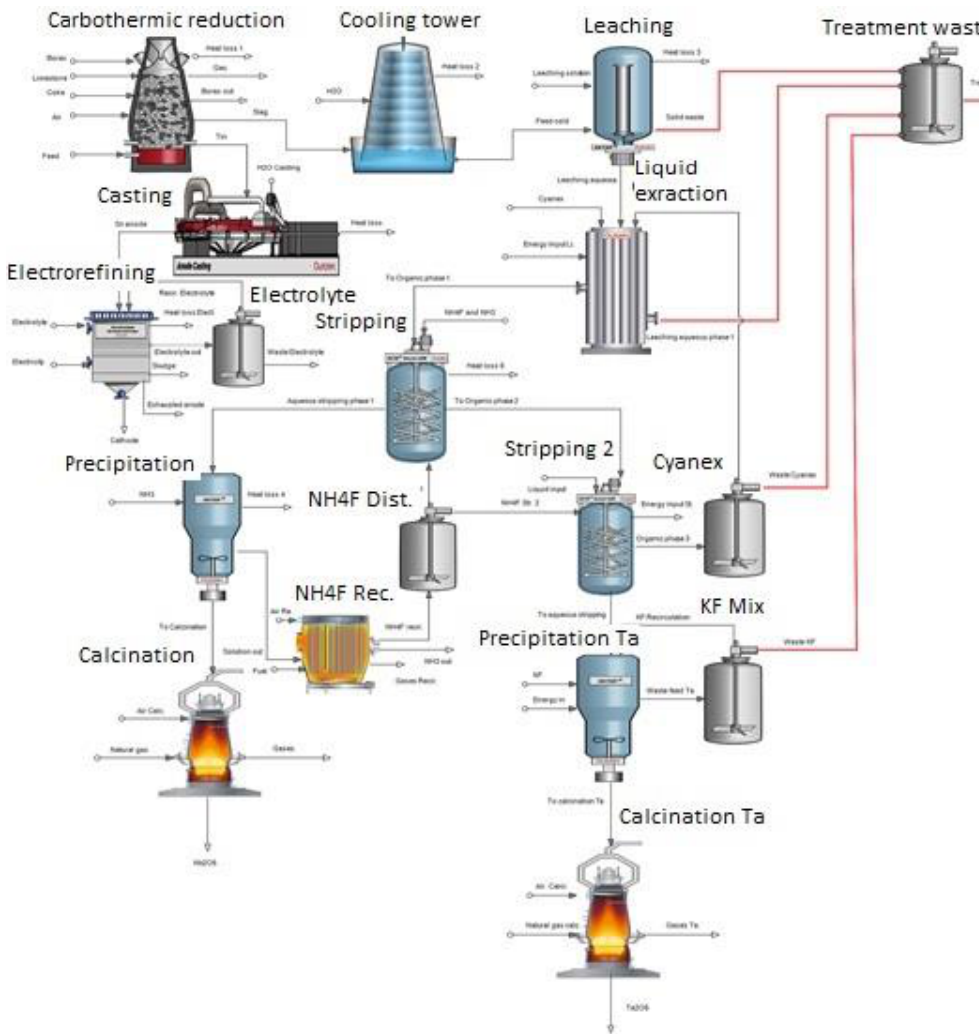
Figure 3. Flowsheet of the process used to recover Sn along with Nb and Ta from the